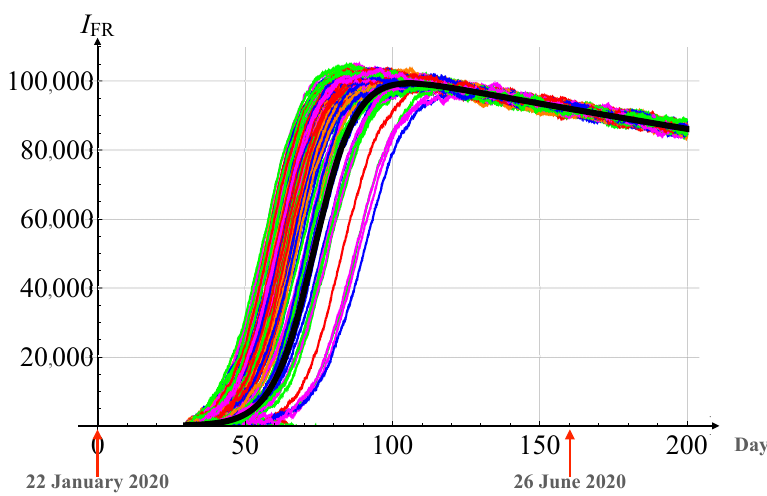
Figure 26. 200 realisations of the stochastic differential equation for France’s first wave. The values of the parameters are those reported in Figure 24. ˜ η = 0.002, which has been estimated according to Equation (65). The black curve is the solution of the deterministic equation.